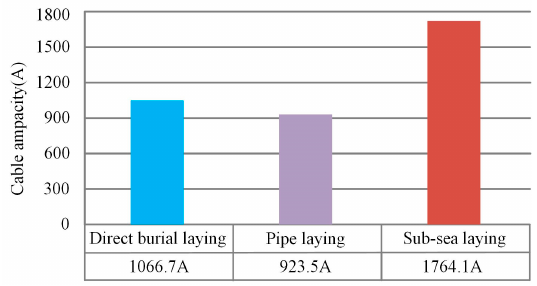
Figure 6. The comparison of the cable ampacity of three laying methods.